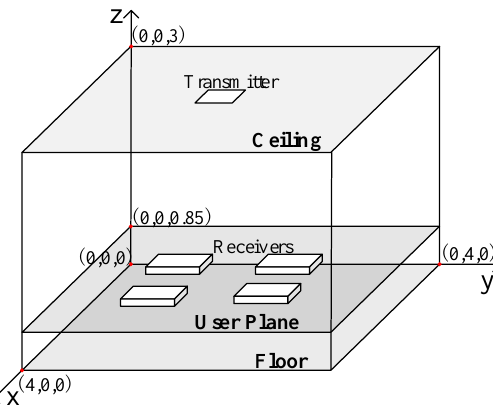
Figure 2. Downlink NOMA system